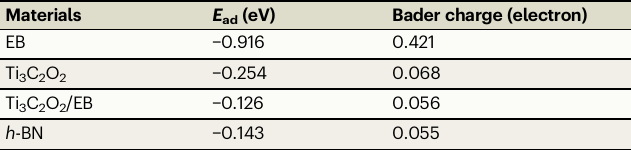
Table 1 | The calculated adsorption energy E ad and Bader charge state that transferred from substrates to adsorbed O 2 molecules